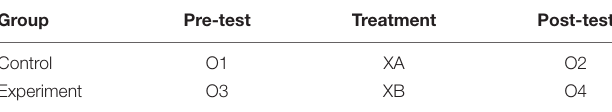
TABLE 1 | Pre-test and post-test research design. Group Pre-test Treatment Post-test Control